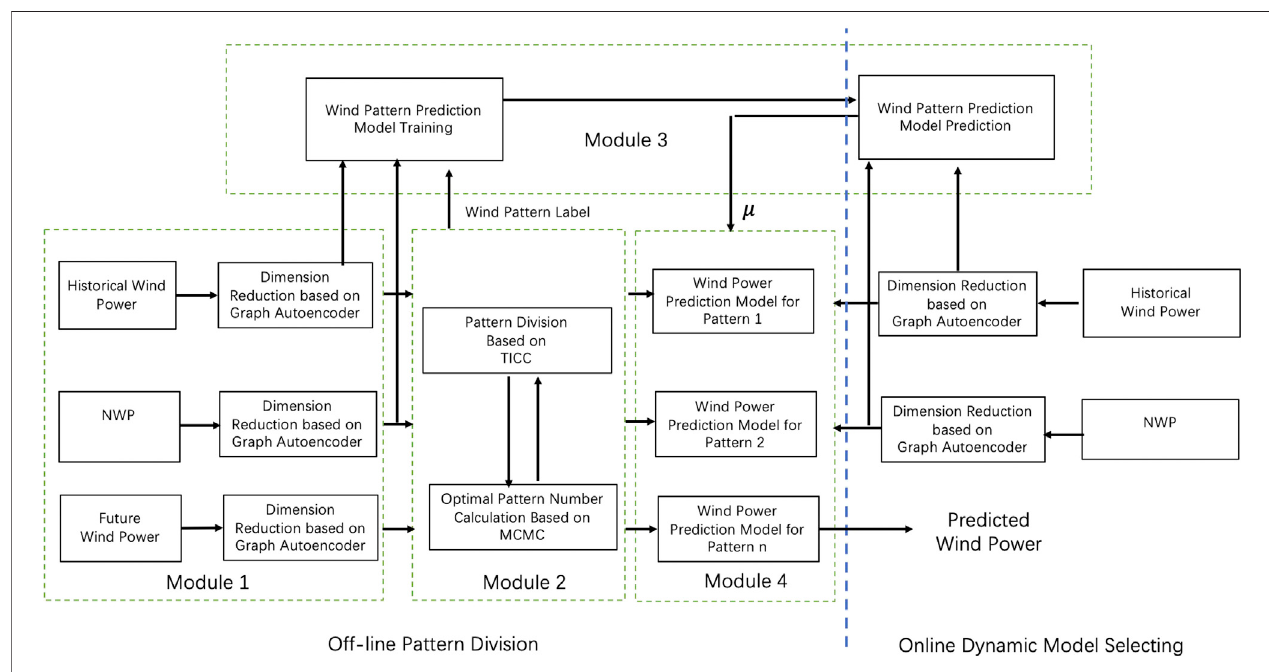
FIGURE 1 | The framework of ultra-short-term wind power